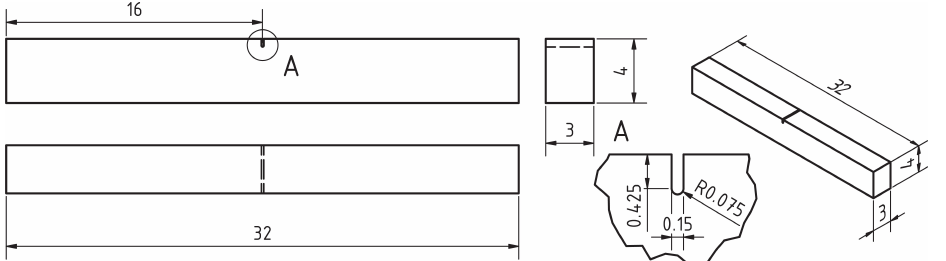
Figure 1. Schematic drawing of the resonance bending fatigue crack growth test apparatus (see [18]).